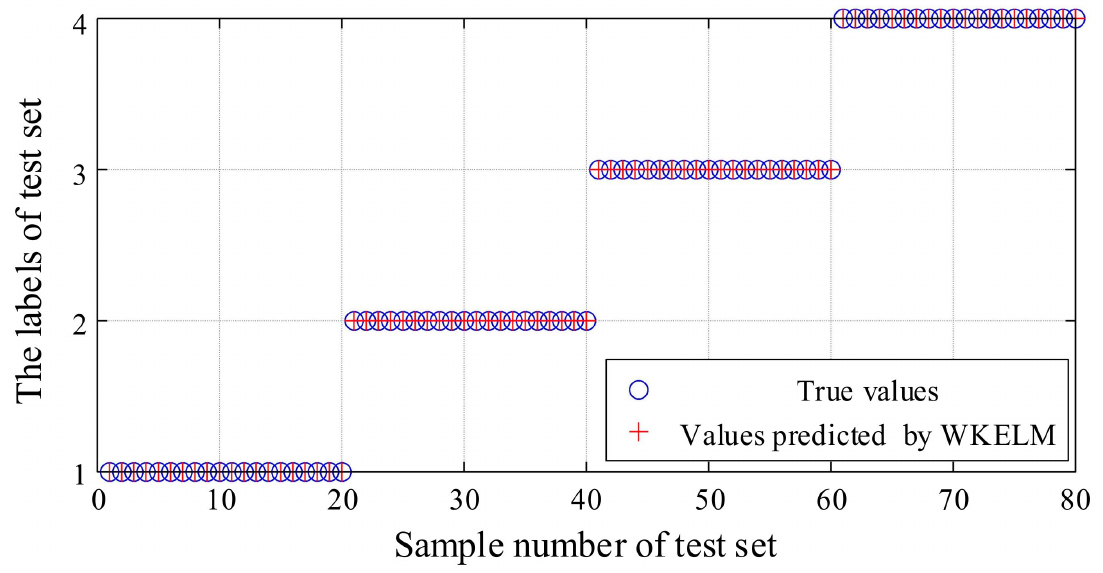
Figure 17. Fault diagnosis of hydraulic pump based on wavelet kernel extreme learning machine